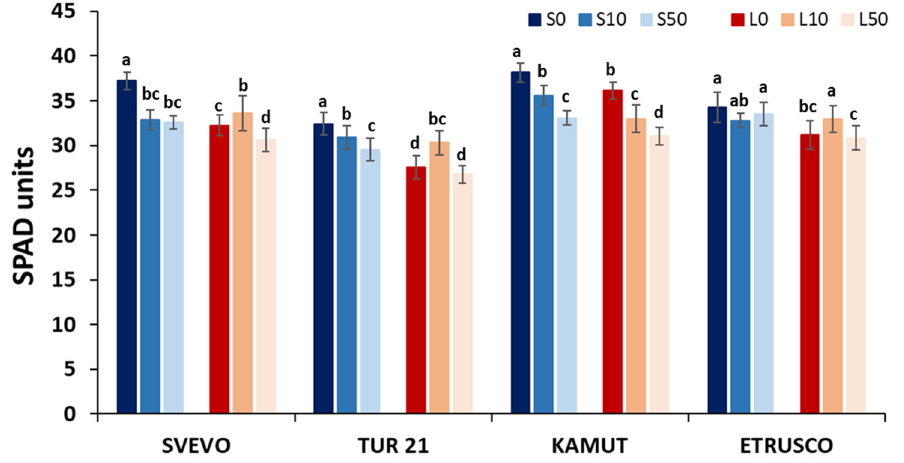
Figure 2. Chlorophyll content. Chlorophyll concentrations were measured using a SPAD meter in the leaves of four wheat genotypes (Svevo, Tur-21, Kamut, and Etrusco). Plants were grown while exposed to different sulfate levels (S and L, 1.2 and 0.06 mM sulfate, respectively) and three different Se levels (0, 10, and 50 mM), provided as selenate. SPAD readings were made using the first fully expanded leaf from the top of the plant. Significant differences between samples are indicated by different letters ( p <